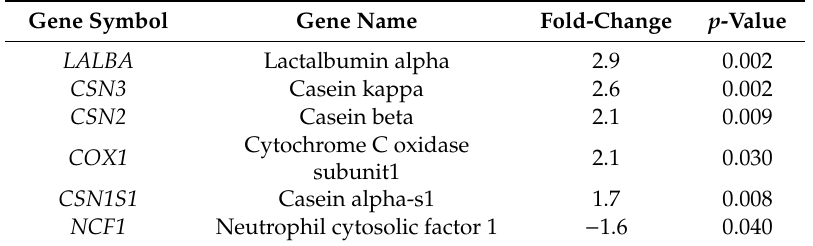
Table 2. The candidate genes with the highest fold-change between preterm infants < 32